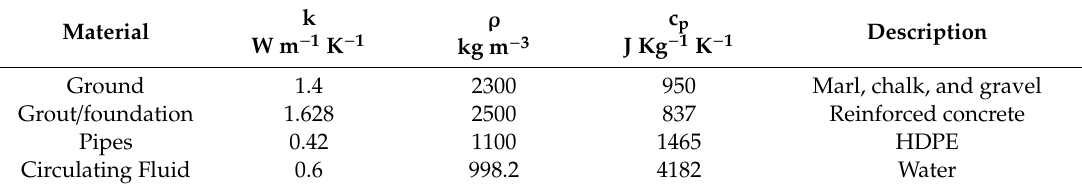
Table 5. Material Table 5. Material properties.